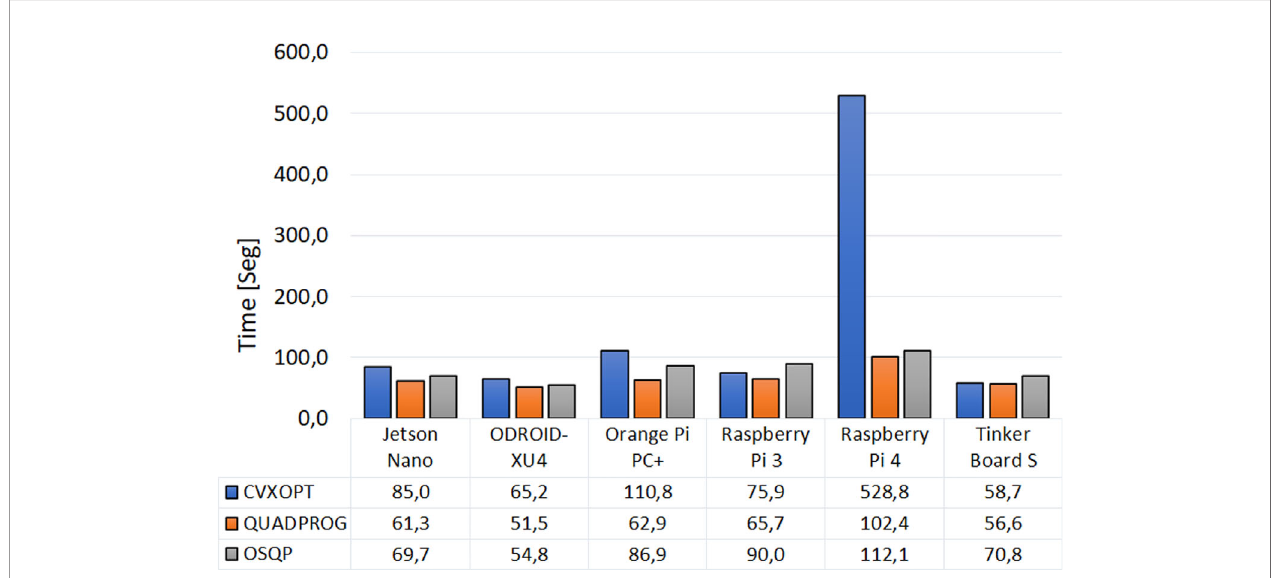
FIGURE 3 | Average time to execute the four MPC strategies with the six embedded systems and per optimization solver